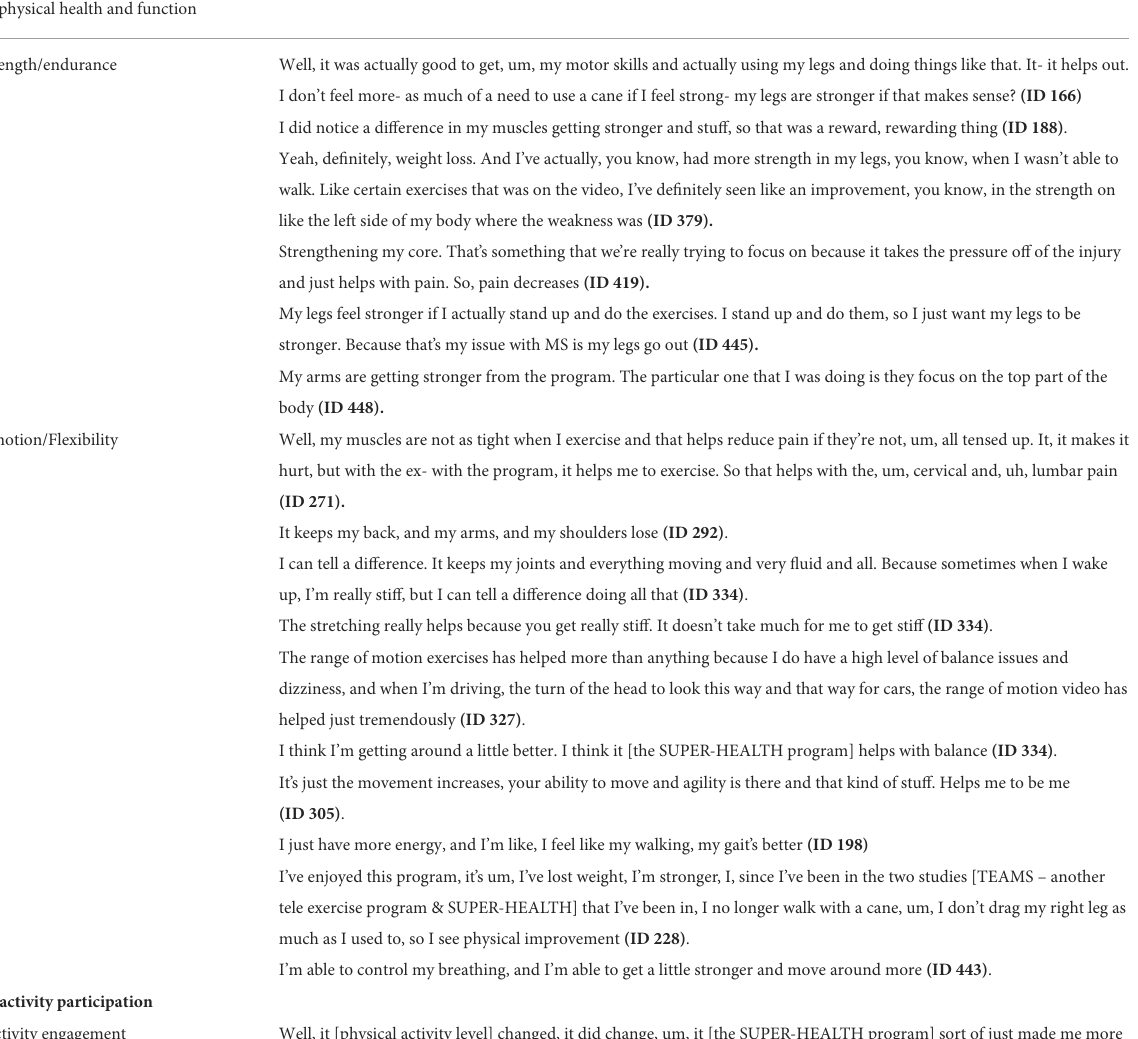
TABLE 1 Themes, subthemes, and illustrative quotes. Improved physical health and